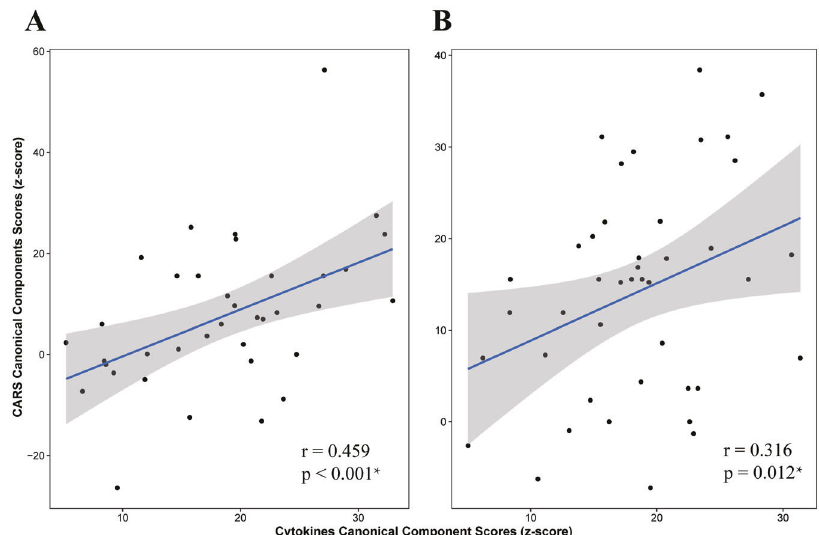
Fig. 1 Sparse canonical correlation analysis. We carried out sparse canonical correlation analysis in A Discovery Set and B Validation Set. The canonical scores between CARS and cytokines, which were min-max normalised and log transformed, were signi fi cant related in both data